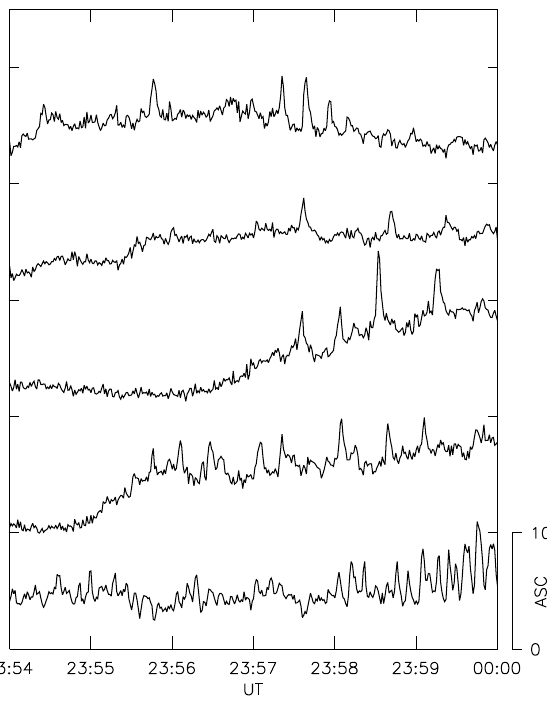
Fig. 3. Variations in the observed auroral brightness at five points within the all-sky camera field-of-view, allowing the temporal vari- ations associated with the pulsating aurora to be determined. The curves have been offset for clarity.